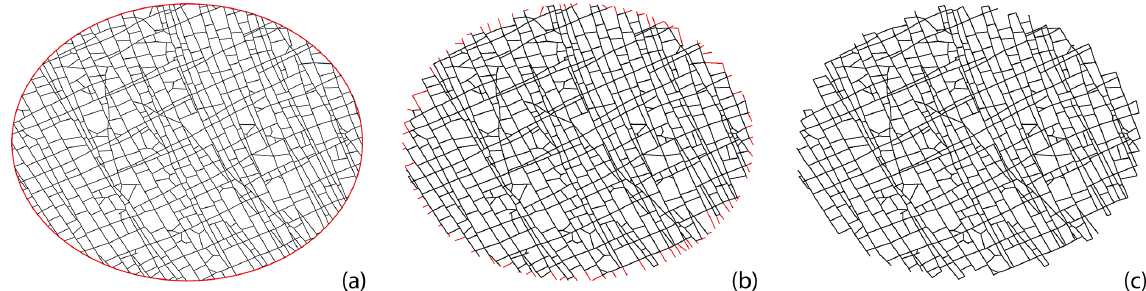
Figure 9. Treating isolated nodes and dangling edges that arise due to circular sampling: (a) a circularly sampled subgraph with a diameter of 7.5m, (b) edges connected to isolated nodes intersected by circle, and (c) subgraph after removing isolated nodes and corresponding dangling